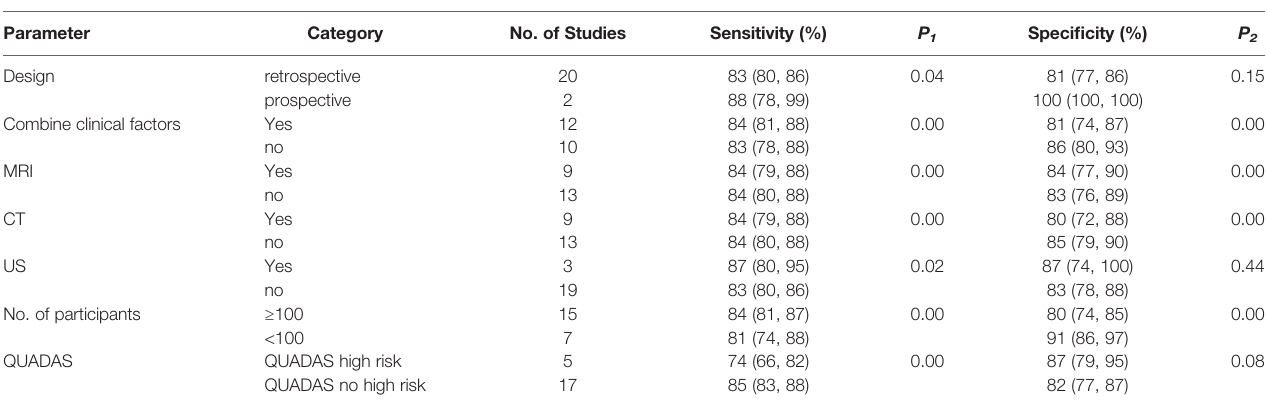
TABLE 3 | Univariable meta-regression and subgroup